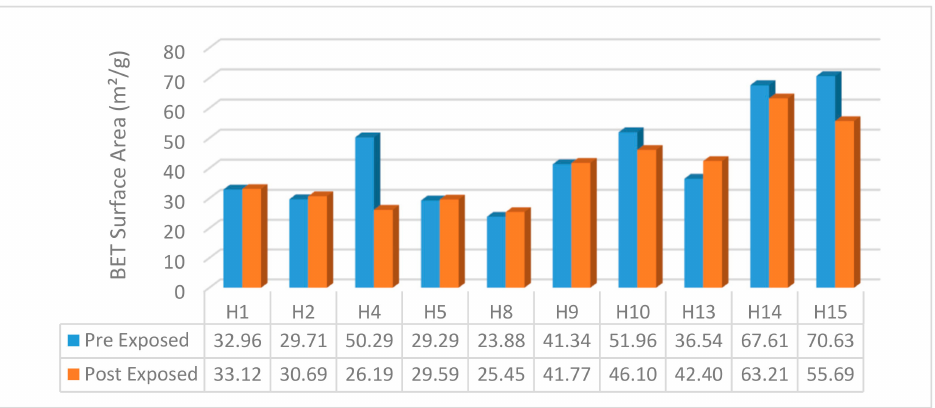
Figure 4. Histogram showing total pore volume derived from maximum pressure for the analysed samples.